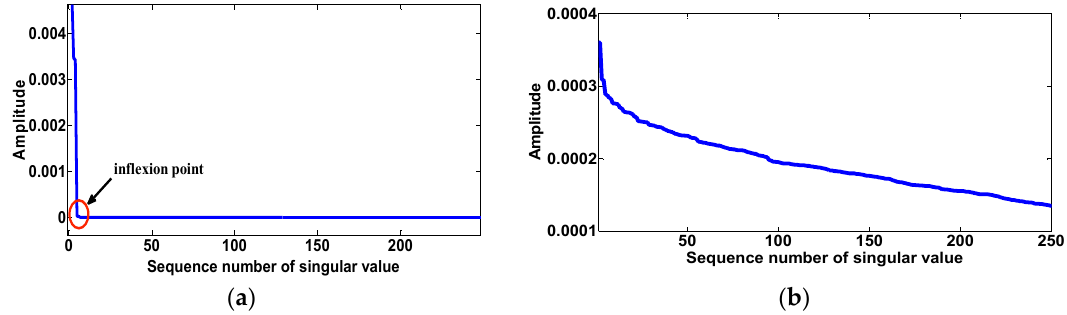
Figure 1. The spectrum of incremental singular entropy about pure signal and noise: ( a ) Spectrum of incremental singular entropy of a pure signal; ( b ) Spectrum of incremental singular entropy of a noisy signal.